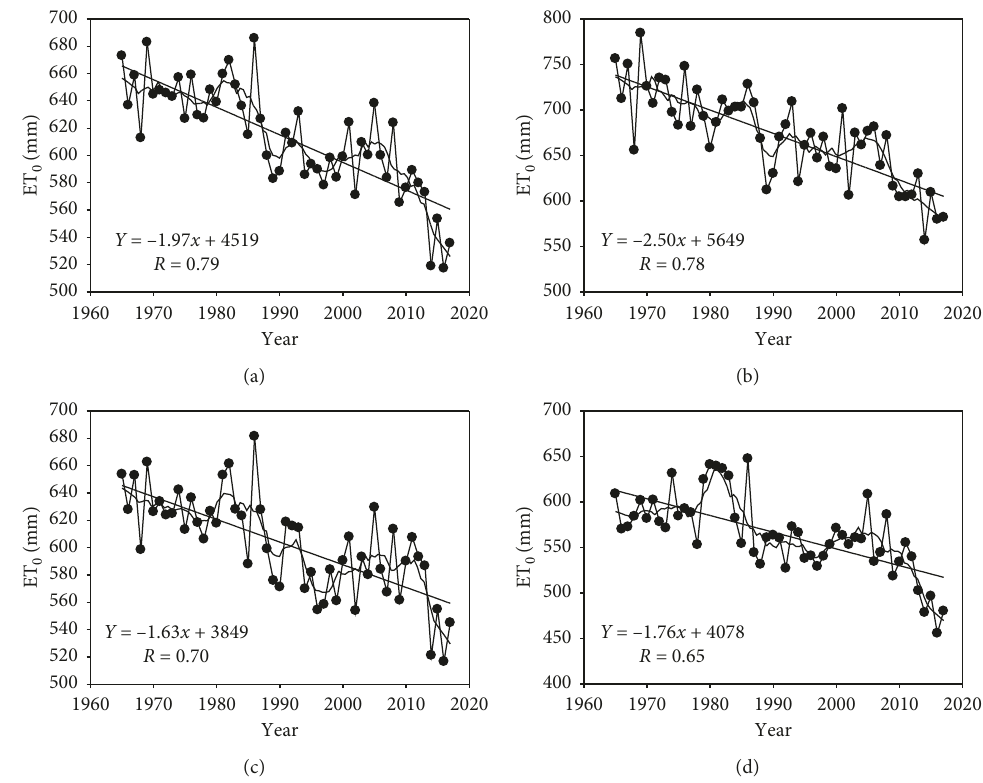
Figure 2: Areal average ET 0 changes over Northeast China during 1965–2017. (a) Northeast China. (b) Liaoning. (c) Jilin. (d) Heilongjiang.